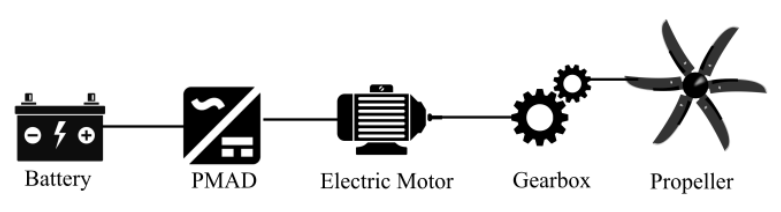
Figure 6. Battery-electric energy network